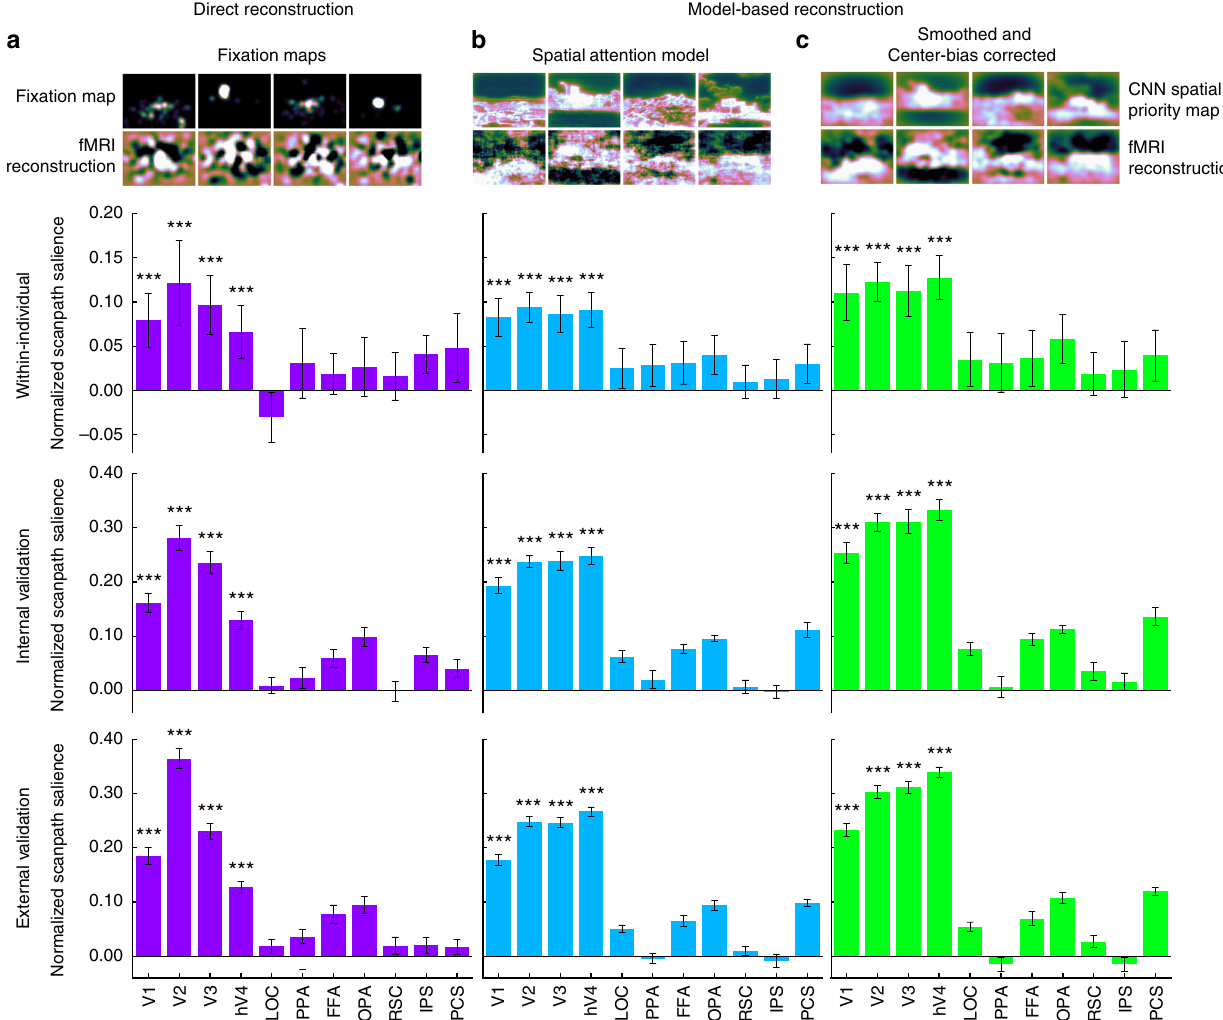
Fig. 1 Spatial reconstructions from fMRI activity predict eye movement patterns. a Fixation maps directly reconstructed from fMRI activity predict eye movement patterns. Example fi xation maps and reconstructed fi xation maps are shown. Positive NSS values indicate that reconstructed fi xation maps predict eye movement patterns. In the Within-individual analysis, reconstructed fi xation maps from one individual were compared to that same individual ’ s eye movement patterns. Error bars represent standard error of the mean across participants ( n = 11). In the internal validation analysis, reconstructions were averaged across participants in a leave-one-subject-out cross-validated fashion and used to predict eye movements in the left-out participant. Error bars represent standard error of the mean across participants ( n = 11). In the external validation analysis, group-average reconstructions from all participants in the main experiment predicted eye movements from participants in an independent external validation data set 19 . Error bars represent standard error of the mean across participant in the external validation data set ( n = 22). Signi fi cance was determined for all analyses using permutation testing. b Model-based spatial priority maps reconstructed from fMRI activity predict eye movement patterns. Example computational spatial priority maps and model-based reconstructions are shown. For all analyses, signi fi cance was determined using permutation testing. c Smoothed and center-bias corrected model-based reconstructions predict eye movements. The reconstructions were spatially smoothed using a 2D Gaussian kernel (SD = 24 px), and center-bias correction was conducted by pointwise multiplying reconstructions with a centered 2D Gaussian kernel (600 × 600 px, SD = 600 px, resized to image resolution). Example computational spatial priority maps and model-based reconstructions are shown. Signi fi cance was determined using permutation testing. * P < 1 × 10 – 2 , ** P < 4.55 × 10 – 3 (Bonferroni-corrected threshold), *** P < 1 × 10 –